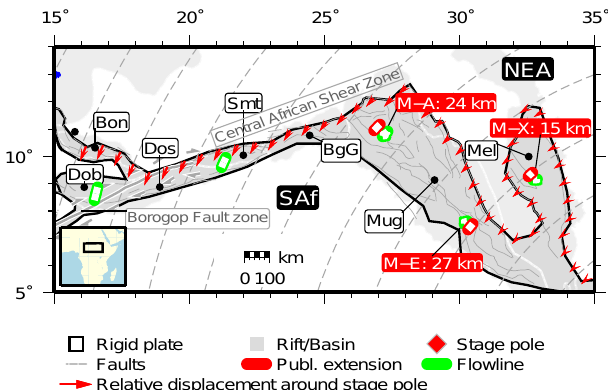
Fig. 6. Stage pole rotation and associated small circles (dashed grey lines) at 2 ◦ spacing for 145–110Ma interval for the Central African Rift System (CARS) and associated relative plate motions at 110Ma. Main rigid plates: SAf – southern Africa; NEA – north- eastern Africa. Main basins and rifts: Bgr – Bongor Basin; Dob – Doba; Dos – Doseo; Smt – Salamat; BgG – Bangara Graben; Mug – Muglad; Mel – Melut; Anza – Anza rift. Red boxes and text indicate published profiles for Melut and Muglad basins and estimated extension values based on McHargue et al. (1992): M-A – profile A-A’; M-E – profile E-E’; M-X – profile X-X’. Vectors shown on map only show relative motions, white core of published profiles and of green flowlines indicates actual amount of exten- sion in km. These are ≈ 24km for profile M-A, ≈ 27km for profile M-E and ≈ 15km for profile M-X during the intial basin-forming phase F1(red; McHargue et al., 1992), with modelled extension of ≈ 30km, ≈ 17km, and ≈ 17km (green), respectively. Red vectors indicate angular displacement of rigid block around stage pole back to fit reconstruction